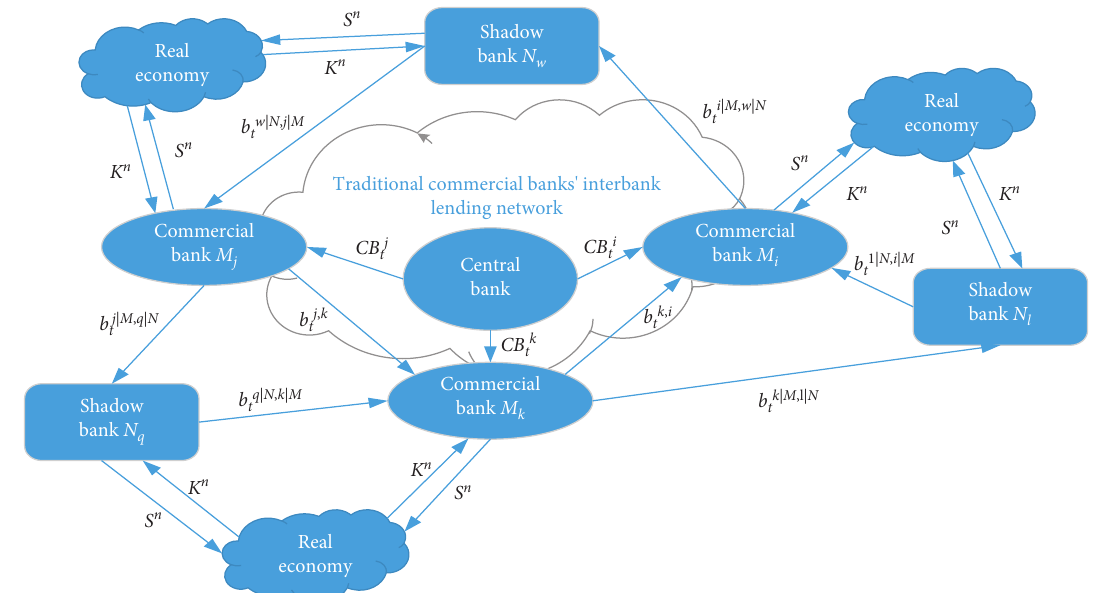
Figure 1: The structure of interbank network with shadow